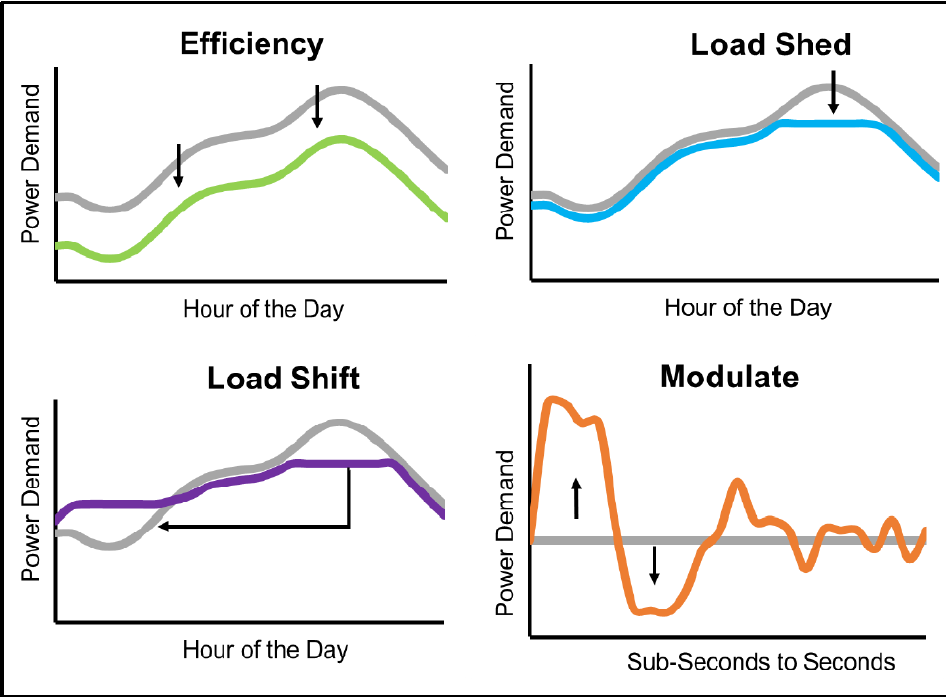
Figure 3. Building flexibility load curves [19]. Reproduced with permission from the U.S. Department of Energy, EERE, 2019.